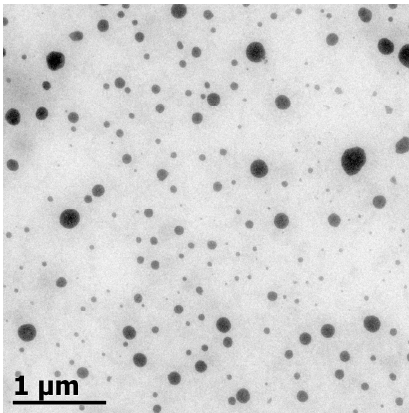
Figure 5. Transmission electron microscopy image of BW–SNs using T80 as emulsifier after microfluidization.